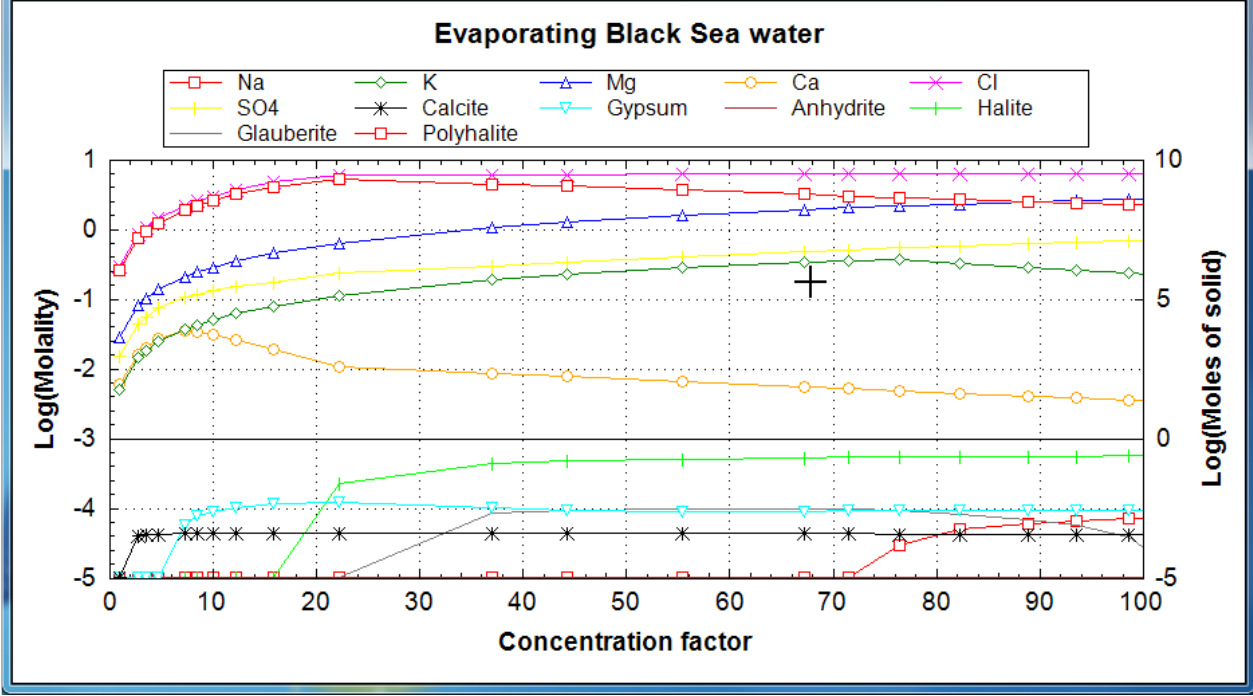
Figure 18. Concentrations in evaporating Black Sea water and precipitated salts, calculated with pitzer.dat